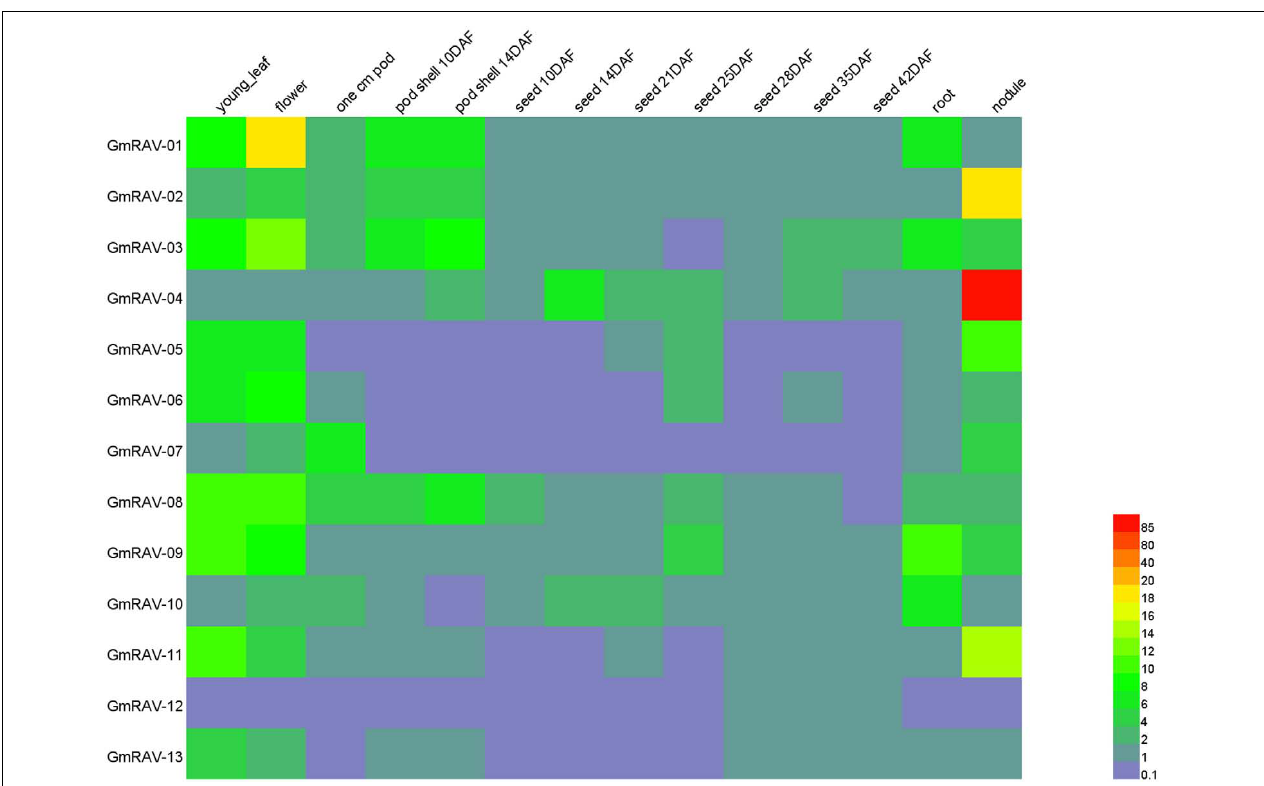
FIGURE 6 | Expressions of soybean RAV genes. Differential expression analysis of RAV genes in